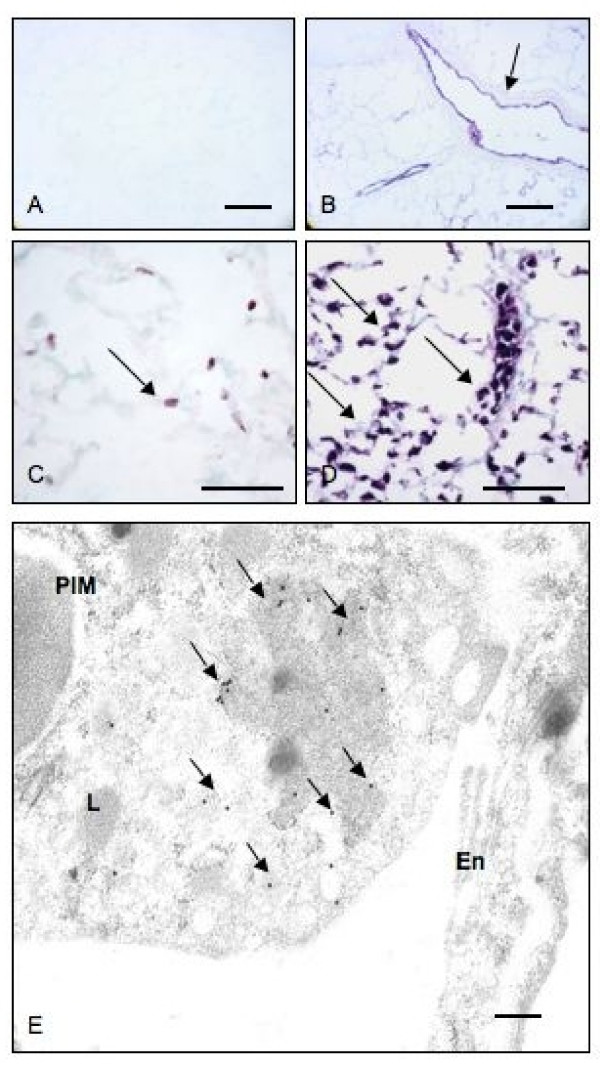
PIM recruitment: Lung section stained with only secondary antibody (A) show no reaction while anti-vWF antibody stained vascular endothelium (arrow). Lung sections from control rats (C) contained occasional septal ED1-positive cells (arrow) while those from BDL rats had numerous reactive cells in the septa (arrows). Immuno-electron micrograph (E) shows gold labeling (arrows) in the cytoplasm as an indication of ED-1 staining in a PIM. En: Endthelium; PIM: pulmonary intravascualr macrophage; L: lysosome. Bar: A-B: 50 μm; C-D: 100 μm; E: 1 μm.